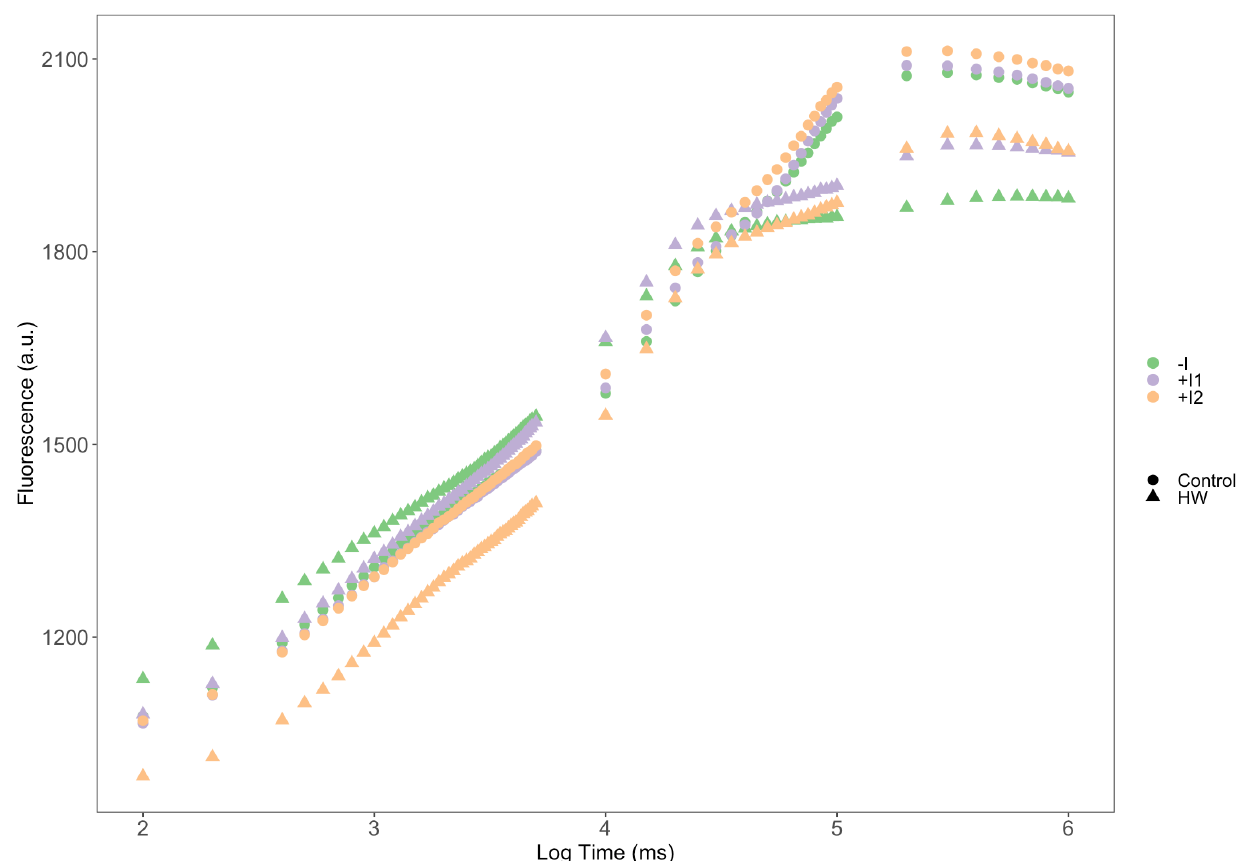
Figure 3. Kautsky fluorescence induction curves of non-inoculated ( − I) and marine PGPR consortia 1- and 2-inoculated (+I) Vitis vinifera dark-adapted leaves, under normal (control) thermal regimes and exposed to heatwave (HW) (N = 5, average).